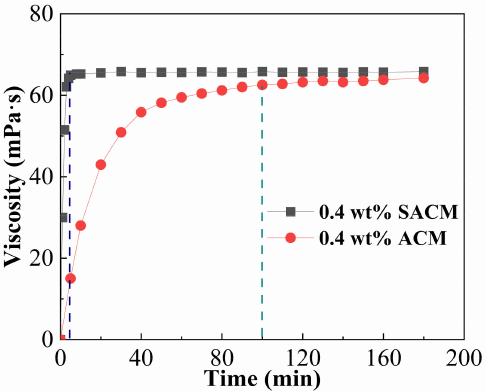
Figure 3. The viscosity–time plots of suspension and powder.